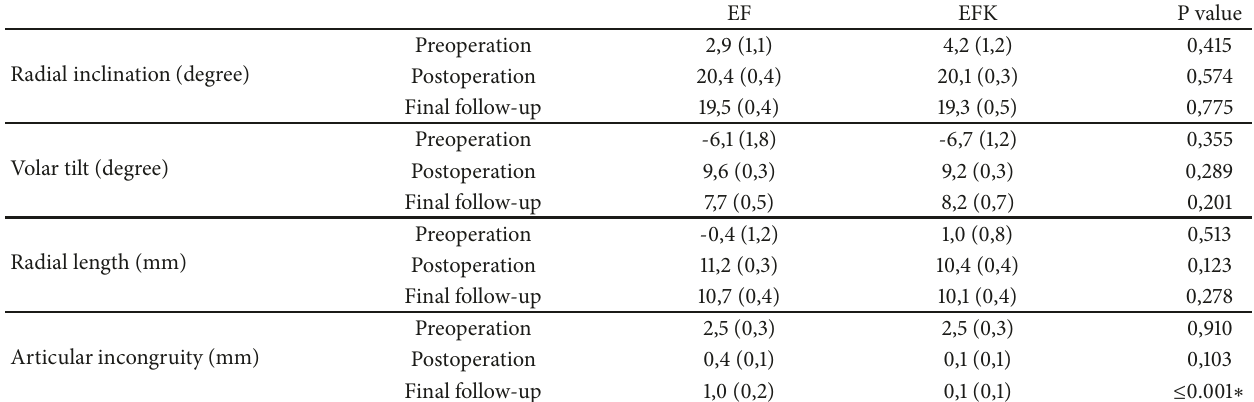
Table 2: Radiographic